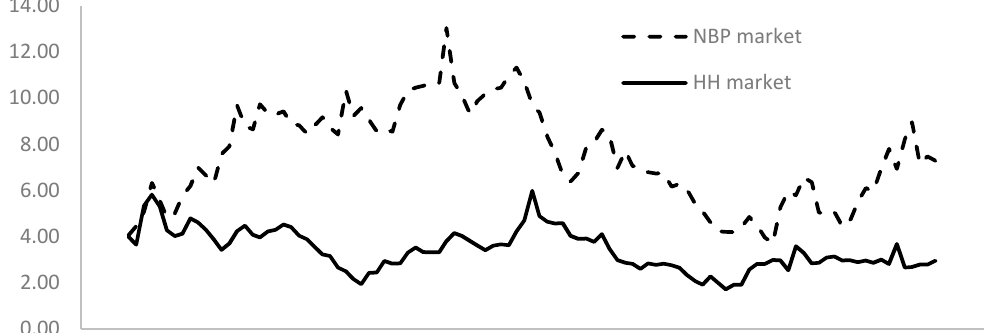
Figure 3. Monthly gas prices of both gas markets, USD/MMBtu.